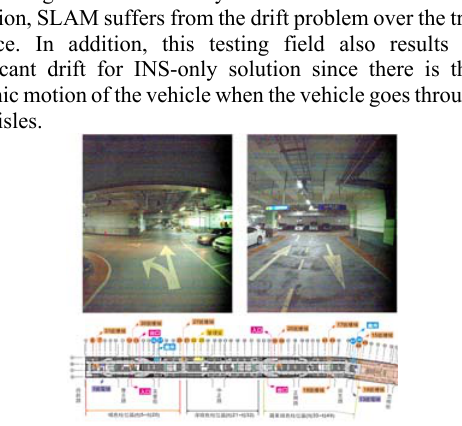
Figure 6. Overview of Hai-an underground parking lot